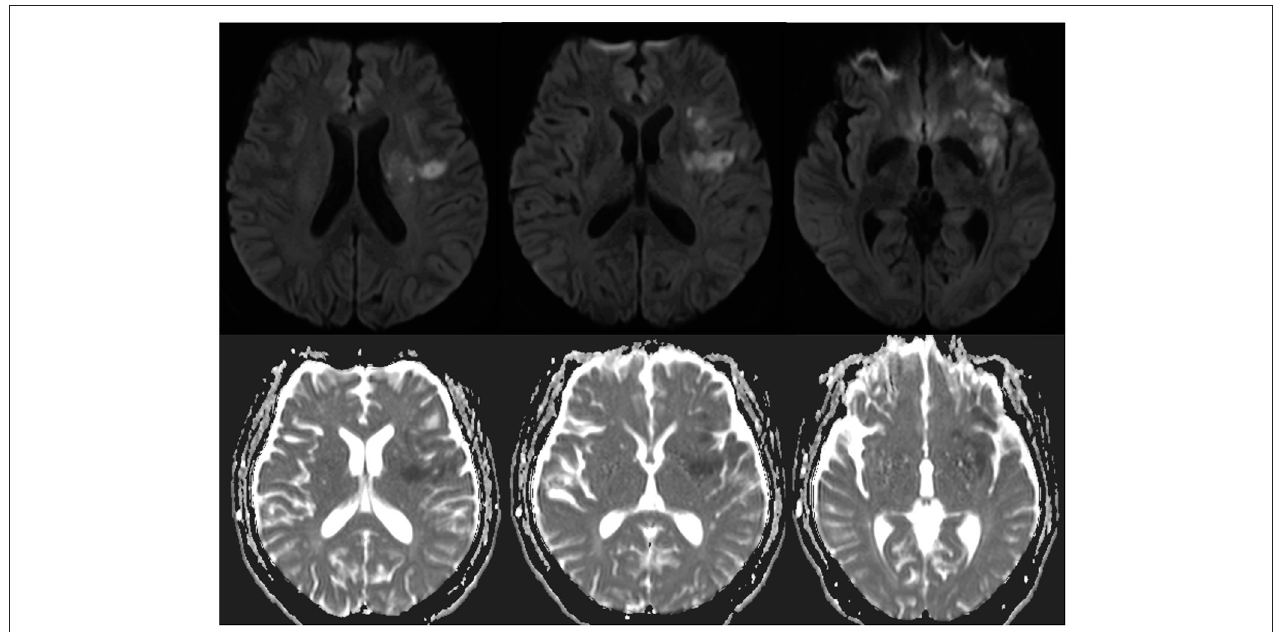
FIGURE 2 | Axial diffusion-weighted image and apparent diffusion coefficient showed acute infarction in the left temporal lobe, left insular lobe, left basal ganglia, and left radial crown 24h after